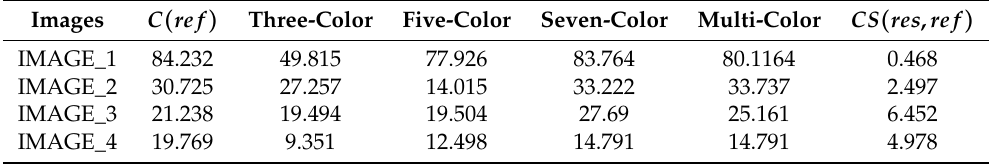
Table 6. Colorful. Generally, the subjective color evaluation of the image is between moderately colorful and quite colorful, that is, when the color degree C is between 33 and 45, the human eye will look more natural [45]. Among all the subjective color evaluations, the color difference of 12 between averagely colorful and moderately colorful is the smallest, so it can be considered that when the color similarity CS ( res , ref ) between the reference image and the result image is less than 12, the two images have similar colors. CS ( res , ref ) just said this color similarity between two images, and CS ( res , ref ) = (cid:107) C ( res ) − C ( ref ) (cid:107) , C ( res ) , and C ( ref ) represent the color richness values of the resulting image and the reference image in